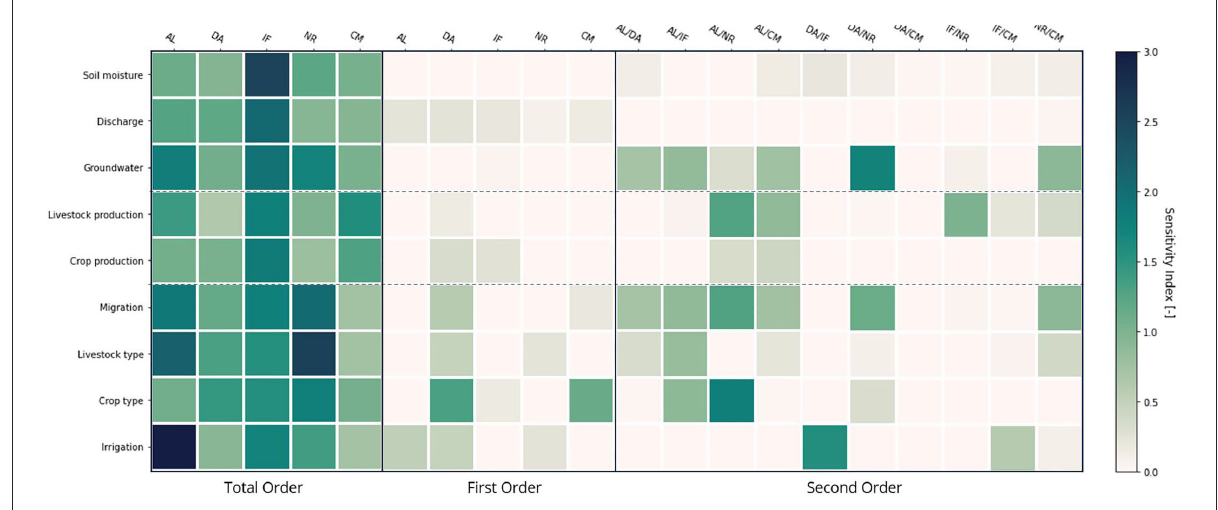
FIGURE8 Results of the sensitivity analysis using three different sensitivity indices (see Section 2.6): total (left columns), first (middle columns) and second order (right columns). See Table 3 for an explanation of the